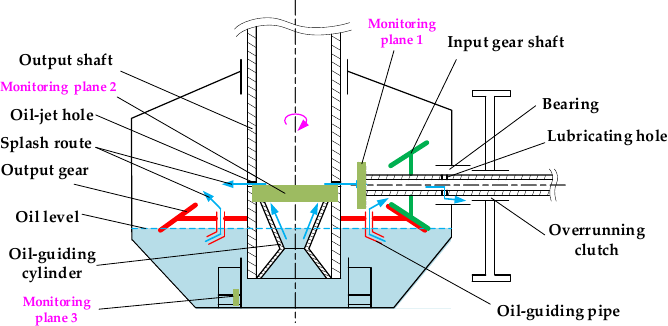
Figure 1. Schematic diagram of a helicopter main reducer oil-guiding splash lubrication system.